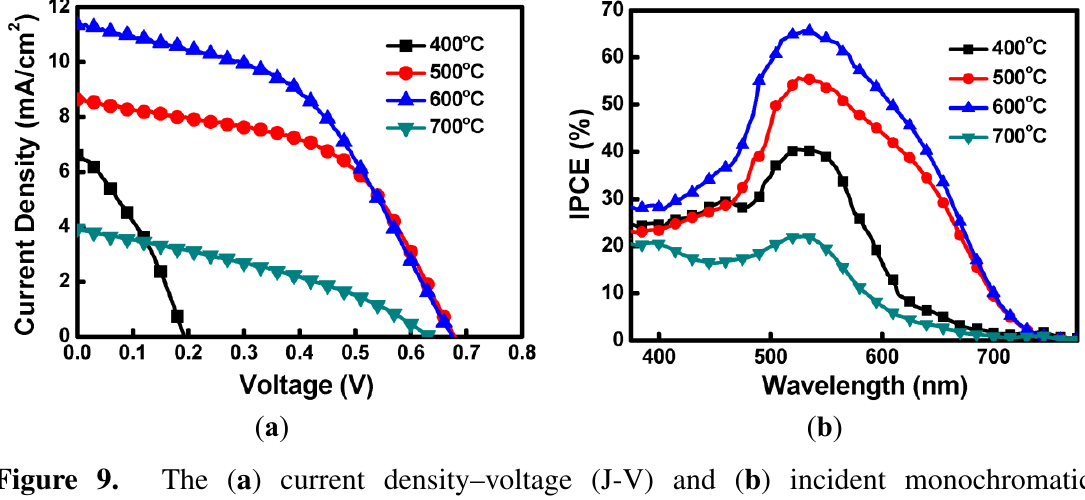
Figure 9. The ( a ) density–voltage (J-V) and ( b ) incident monochromatic photon-to-current conversion efficiency (IPCE) curves of DSSCs using various Cu 2 O counter electrodes. Table 1. The characteristics of device short-circuit current density (Jsc), open-circuit voltage (Voc), fill factor (FF), and device efficiency based on various Cu 2 O counter electrodes.